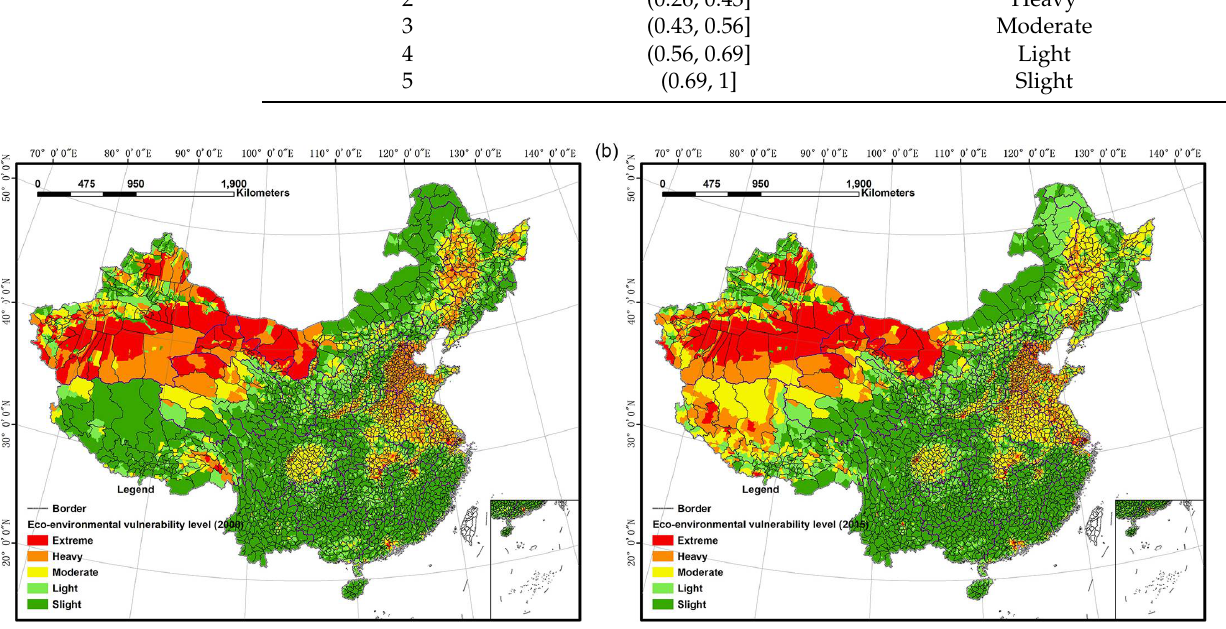
Table 6. Detailed information on the villages and towns at each grading level.